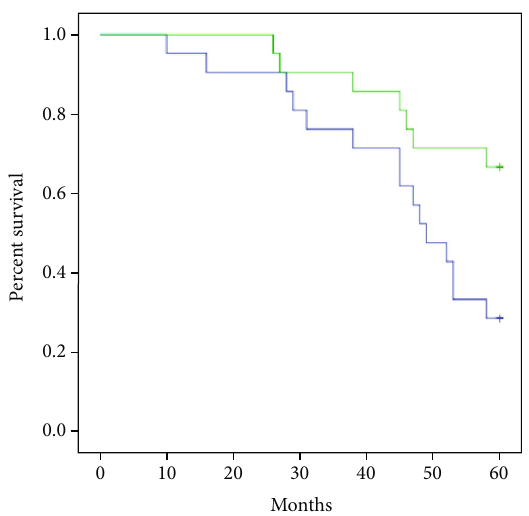
Figure 3: Kaplan-Meier survival curves depicting overall survival rate among high dose group (green line ) and low dose group ( blue line ). The curative e ff ect of the study group is better than that of control groupLog Rank =5.418P